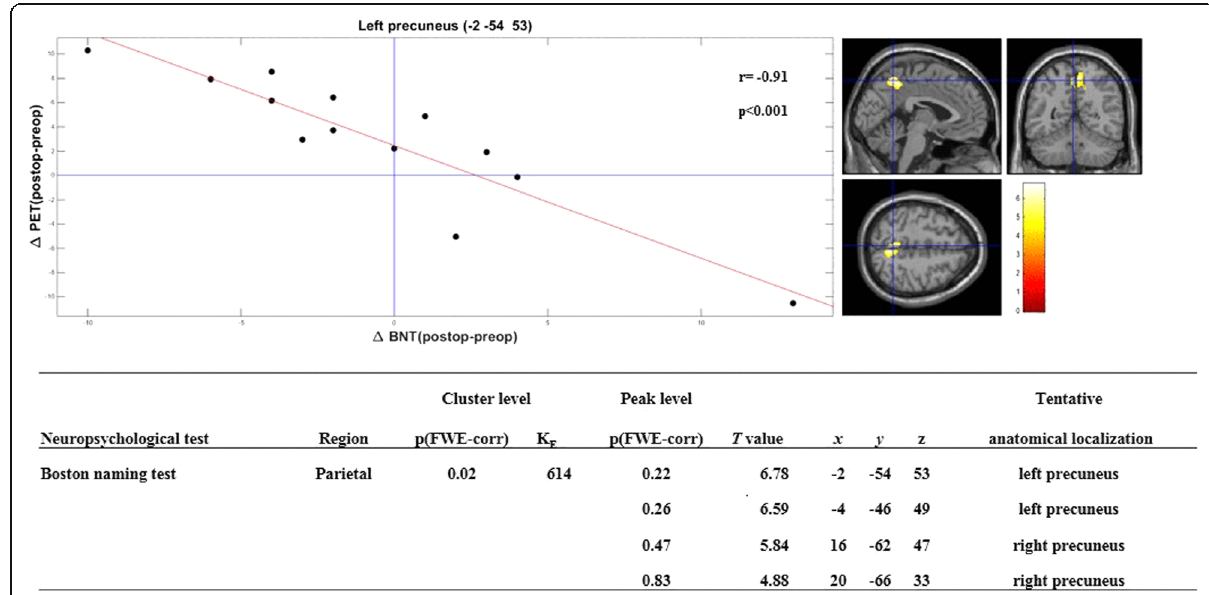
Fig. 2 Negative correlation between Boston Naming Test (BNT) and metabolic changes after epilepsy surgery in the precuneus. The blue cross is positioned in the left precuneus ( x , − 2; y , − 54; z , 53). Changes in metabolism and neuropsychological test were calculated as the postoperative values minus the preoperative corrected FDG-PET images. SPMt maps were thresholded at uncorrected p < 0.001 at the voxel level combined with a FWE-corrected p < 0.05 at the cluster